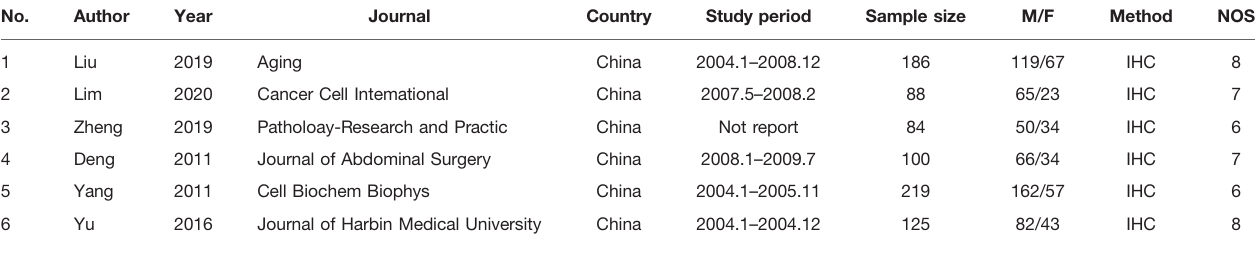
TABLE 1 | Main characteristics and results of each study. No.